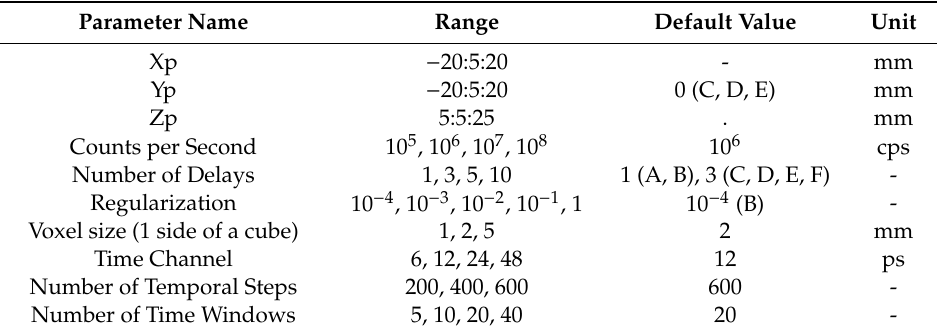
Table 2. Ranges and default values of the parameters under